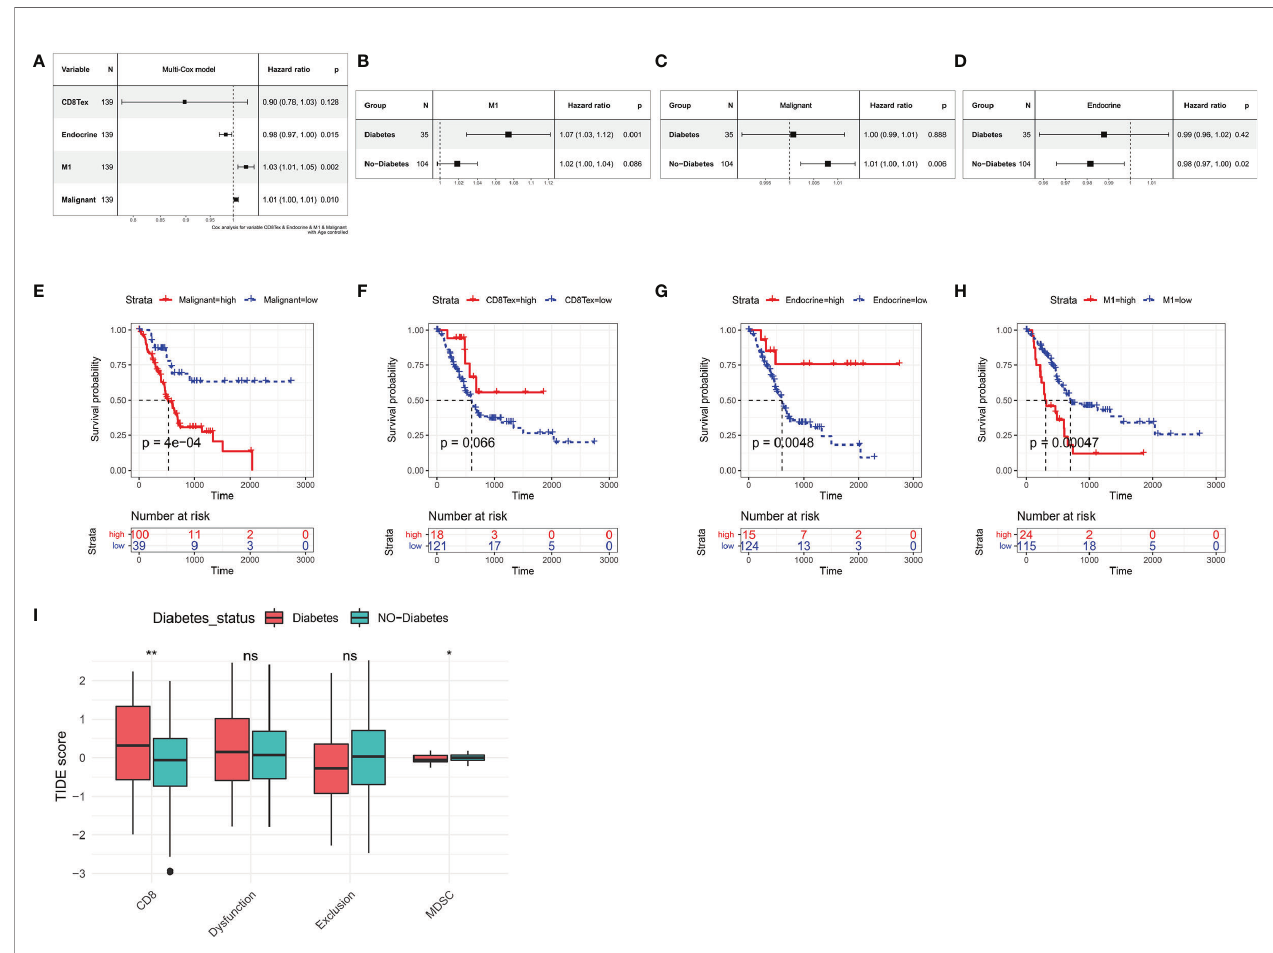
FIGURE 5 | Relationship between tumor microenvironment components and prognostic survival of cancer patients in the TCGA PAAD dataset. (A) Relationship between the proportion of CD8Tex, Endocrine, M1, Malignant in the tumor microenvironment and the prognosis of PAAD patients. (B) Relationship between immune in fi ltration of M1 cells and prognostic survival in diabetic and non-diabetic pancreatic cancer patients. immune in fi ltration of M1 cells is a high risk factor in diabetic pancreatic cancer patients. (C) Relationship between in fi ltration of Malignant cells and prognostic survival in diabetic and non-diabetic pancreatic cancer patients. In non-diabetic pancreatic cancer, in fi ltration of Malignant is a high risk factor. (D) Association of Endocrine cell scoring in the tumour microenvironment with prognostic survival in patients with diabetic and non-diabetic pancreatic cancer. In patients with non-diabetic pancreatic cancer, the proportion of Endocrine was a bene fi cial factor. (E – H) The Absolute scores of Malignant, CD8Tex, Endocrine, and M1 were used to group PAAD patients and compare the differences in prognostic survival between patients in higher and lower groups, respectively. (A – D) All used one-way cox proportional regression models to assess HR for risk factors, logrank was used to test the statistical signi fi cance of the results, and all used the patient ’ s age as a correction factor. (I) TIDE computational framework to assess the immune functional status of the tumour microenvironment. ns, Not Signi fi cant, *p < 0.05, **p < 0.01, ***p <